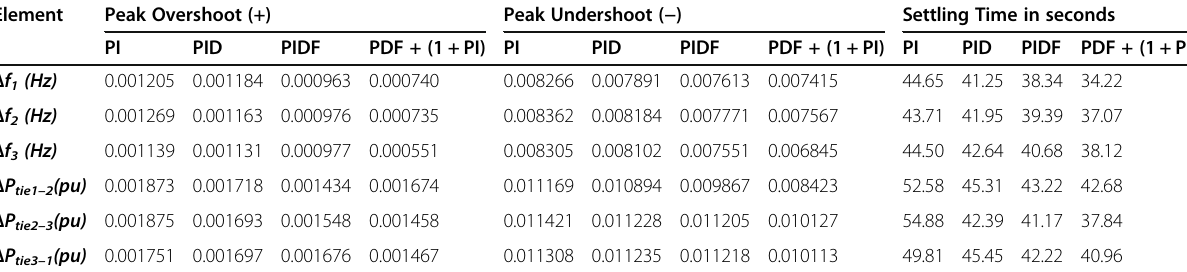
Table 2 Peak deviation and settling time for effectiveness measurement of PDF plus (1 + PI) controller Element Peak Overshoot (+) Peak Undershoot ( − ) Settling Time in seconds